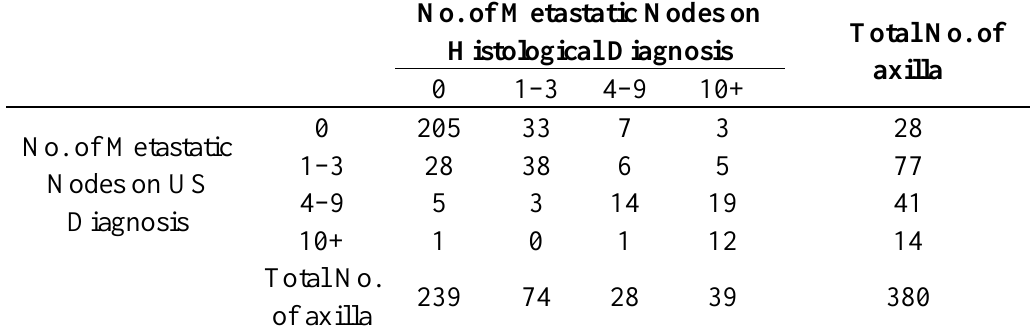
Table 2. Comparison between preoperative and histologic diagnosis according to the number of lymph node